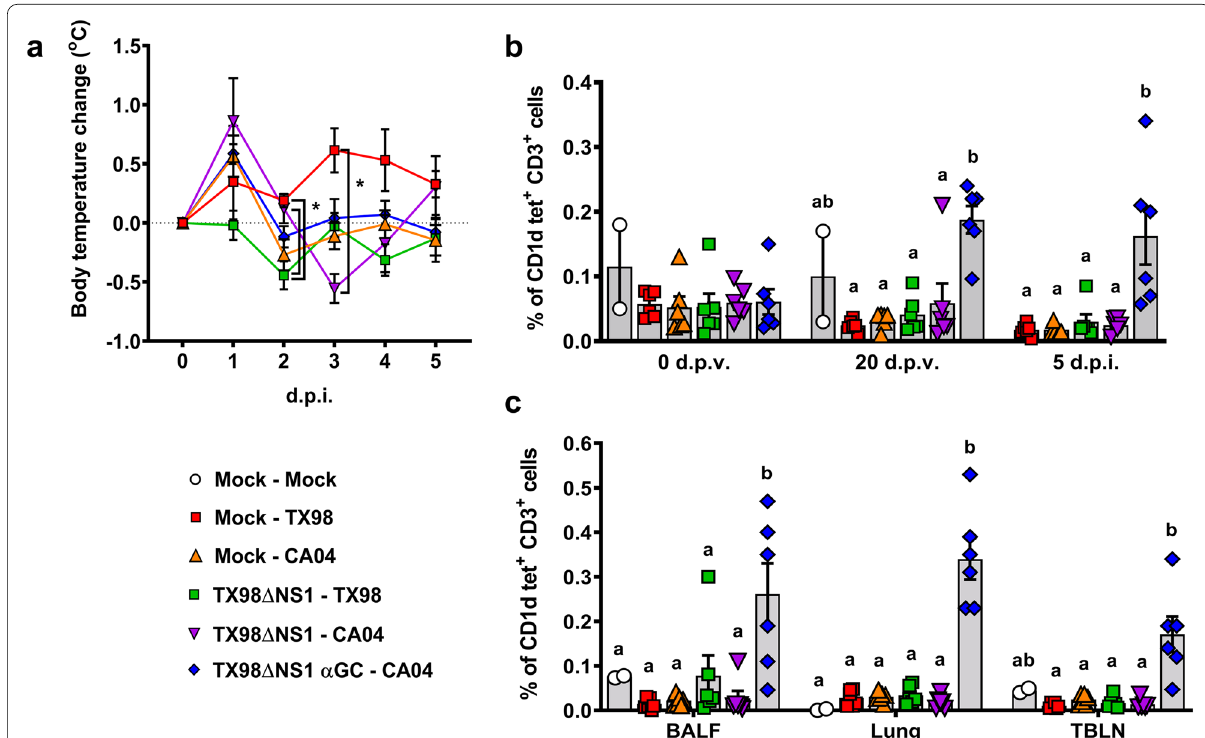
Fig. 2 Body temperature and NKT cell frequencies. a Change in body temperature during the challenge period was based on the average of the -1 and 0 d.p.i. body temperatures. b NKT cells as a proportion of peripheral blood CD3 + lymphocytes at 0 and 20 d.p.v. and 5 d.p.i.. c NKT cells as a proportion of CD3 + lymphocytes in BALF, lung tissue, and TBLN at 5 d.p.i.. Differences between treatment groups were determined by Tukey’s multiple comparisons test. A statistically significant difference between two groups is indicated by a star ( a ) or different letters ( b , c ). Data are represented as mean SEM. Symbols represent treatment groups ( a ) or individual pigs ( b , c ±